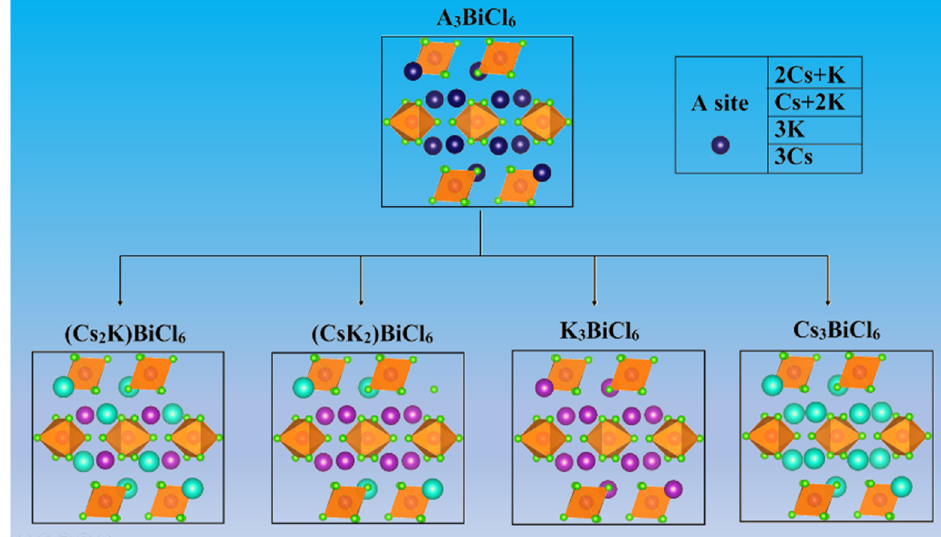
Figure 1. A-site regulation of 0D A 3 BiCl 6 .